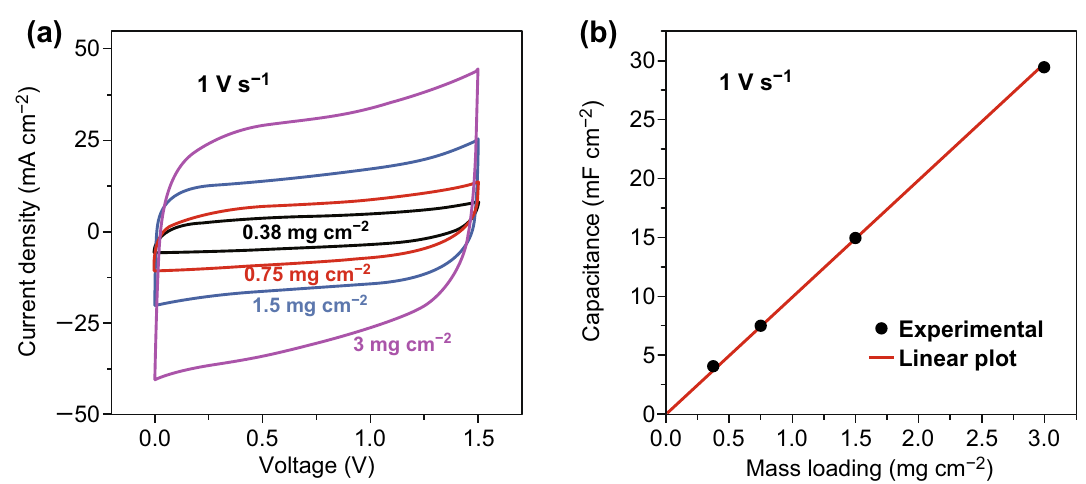
Fig. 7 a CV curves of TiN paper SSC with different mass loadings collected at a scan rate of 1 V s −1 . b Areal capacitance of TiN paper SSC is plotted as a function of TiN mass loading. The linear solid line is a guide to the